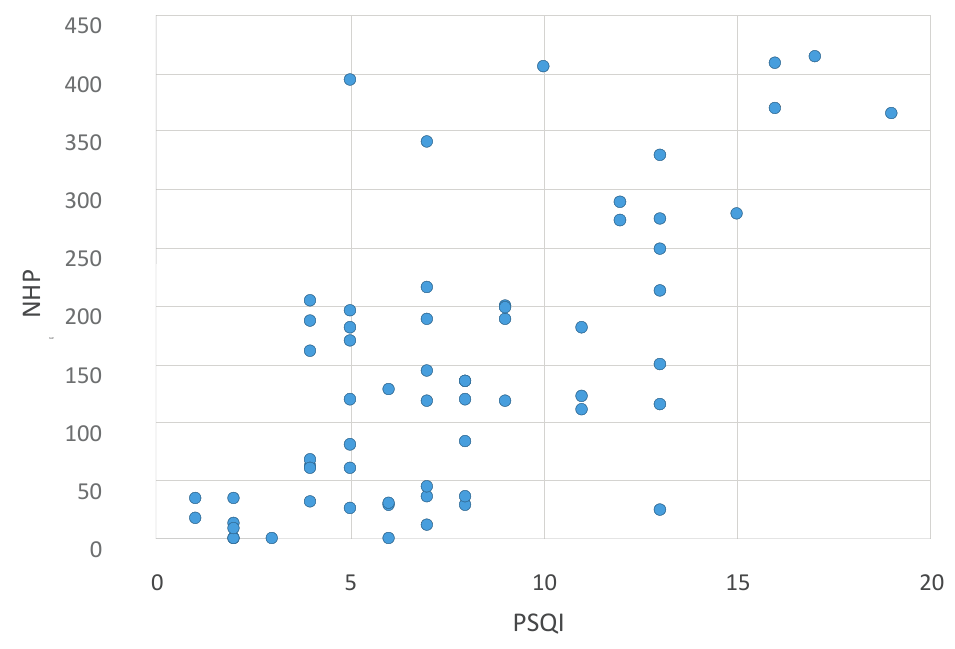
Figure 5. Correlation between NHP and PSQI values. Abbreviations: NHP = Nottingham Health Profile; PSQI = Pittsburgh Sleep Quality Index [6].